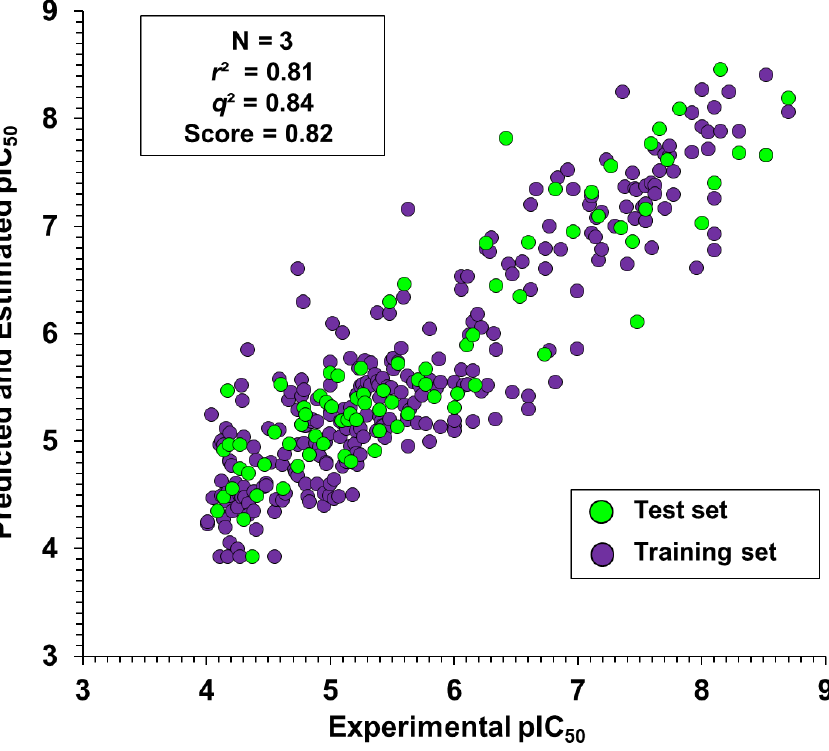
Figure 6. Experimental versus KPLS-predicted values of trypanocidal activity (pIC 50 ).